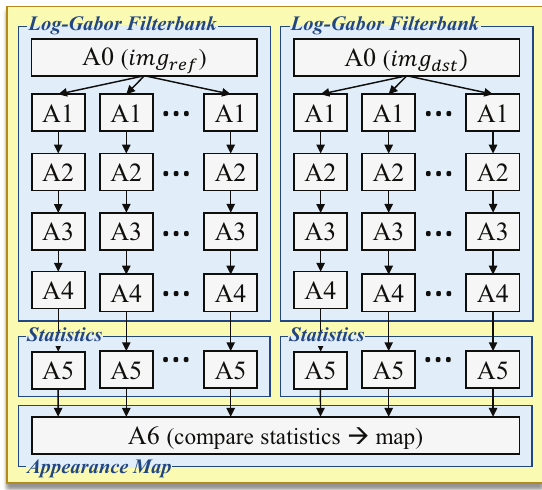
Figure 4. Graphical illustration of the flow of CUDA kernels used in MAD’s appearance